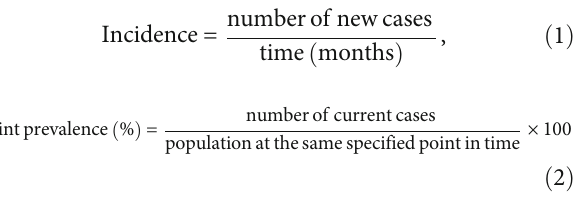
Figure 2: Flow chart of study